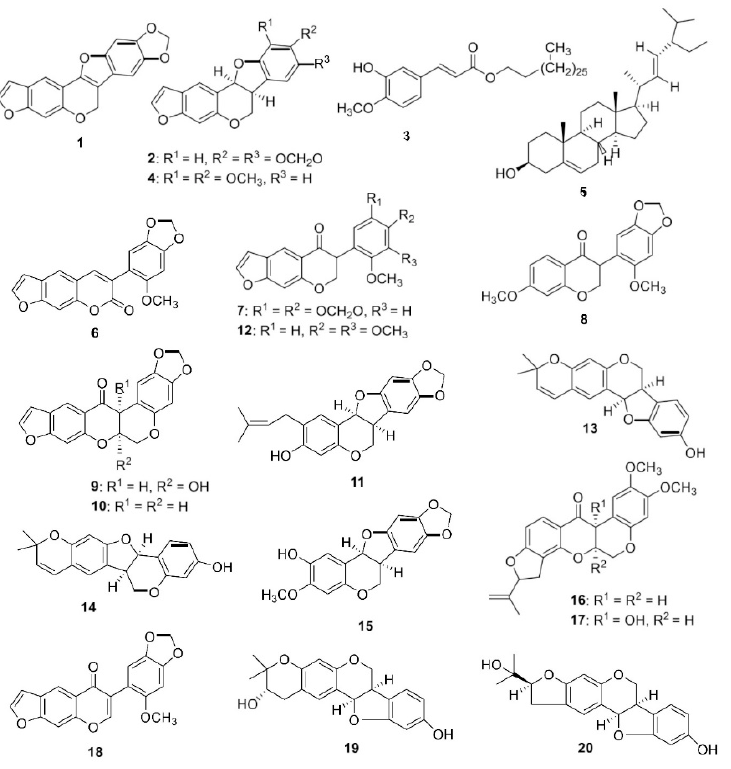
Figure 1. Compounds isolated from the DCM and aqueous root extracts of N. mitis